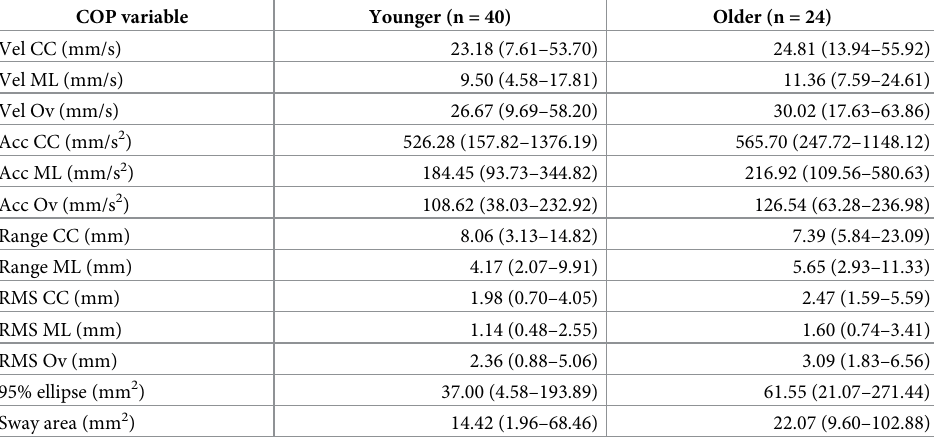
Correlation between COP variables. A multivariate analysis pooling the data of both group of dogs for all the measurements, showed that all variables were significantly correlated (p < 0.05). Highest correlations were found between variables at the same direction, in partic- ular between Vel and Acc; range and RMS; sway area and 95% ellipse area; and 95% ellipse area and RMS. Lowest correlations were found for Acc and Vel with all the other variables (Table 3). Older dogs showed a higher COP displacement than younger dogs. The median and ranges of each COP variable in younger and older dogs are shown in Table 4. All parameters were higher in the older dogs. A stepwise regression analysis including all COP variables as possible predictors of the group (i.e. younger vs. older) revealed that approximately 23% of the variance was explained by two independent variables; RMS Ov and Acc CC (R 2 = 0.23, χ 2 (2, N = 64) = 19.31, p = < 0.0001). The model including these two variables had an excellent accu- racy to discriminate between both groups, with an area under the ROC curve of 0.80. Table 4. Median and range values of each COP variable in younger and older